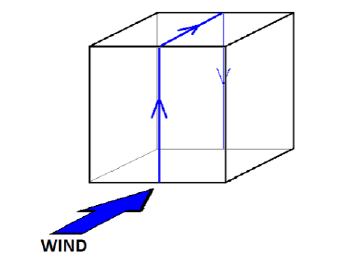
Figure 3. Placement of the pressure taps [45]. Adapted with permission from Ref. [45].